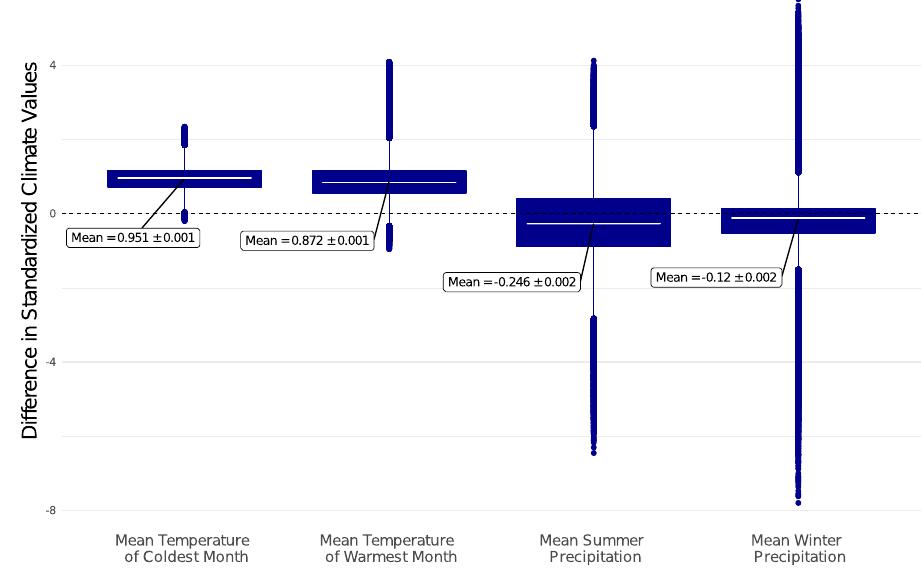
Fig. 5 Recent climate change over the study area. Difference between average 1981 – 2010 climate and average 1961 – 1990 climate across the study area (n grid-cells = 886,911), showing 95% con fi dence interval and range (standardized by Z score). Boxplots include the median line, a box denoting the interquartile range, whiskers denoting values ± 1.5x the interquartile range, and points denoting all outliers. Changes in all climate variables were statistically signi fi cant (two-sided t -test, with p < 2.2e − 16 for each climate variable). The temperature variables increased at a greater magnitude than the precipitation variables decreased. Source data are provided as a Source Data fi